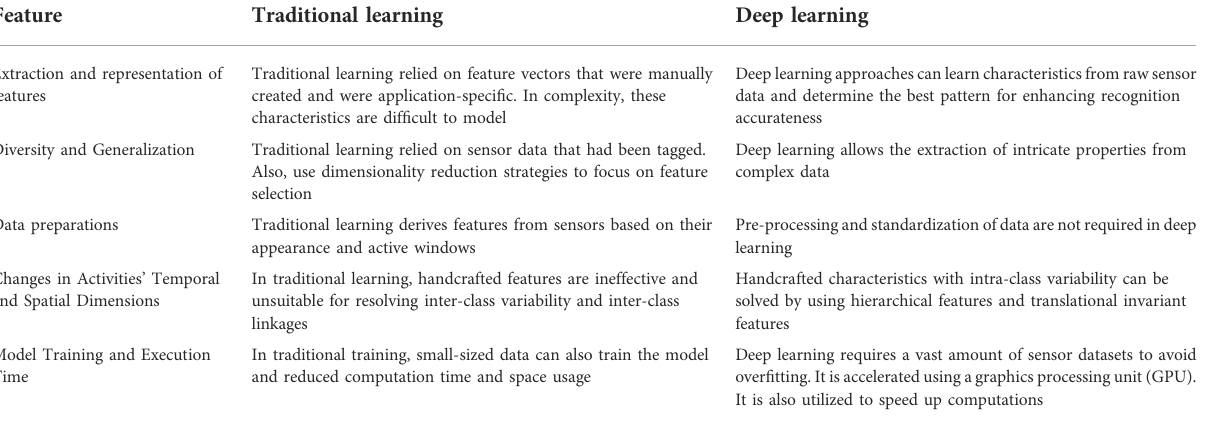
TABLE 1 Distinction between deep and traditional